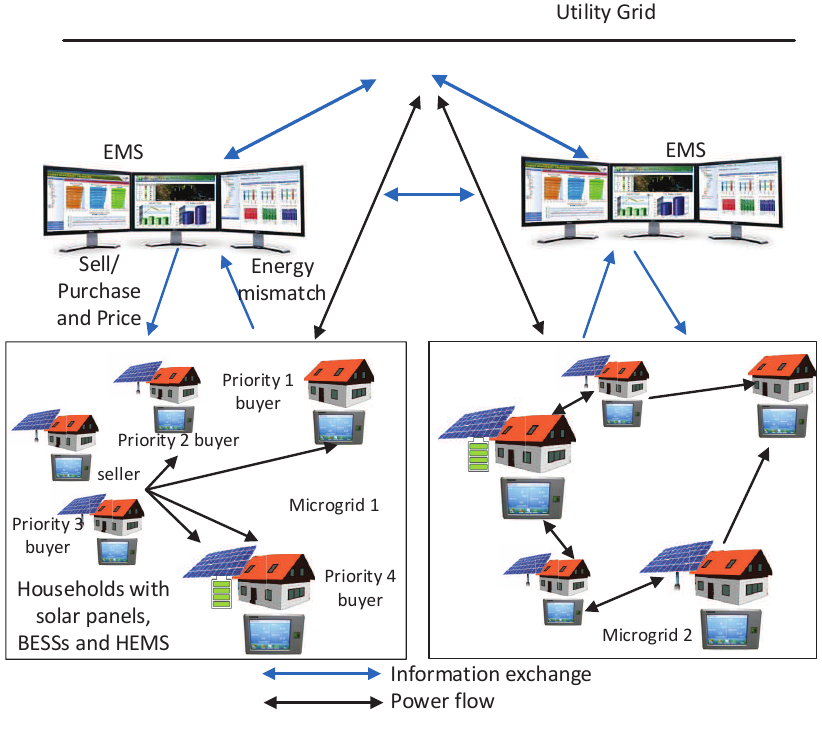
Figure 1. Local energy trading within a microgrid, as well as multiple microgrids. The microgrid 1 on the left hand side shows the different priority classes for buyers. Note that the priorities of the houses can be different based on the energy deficit and the thresholds. Each microgrid has a central EMS which coordinates the energy trading with another